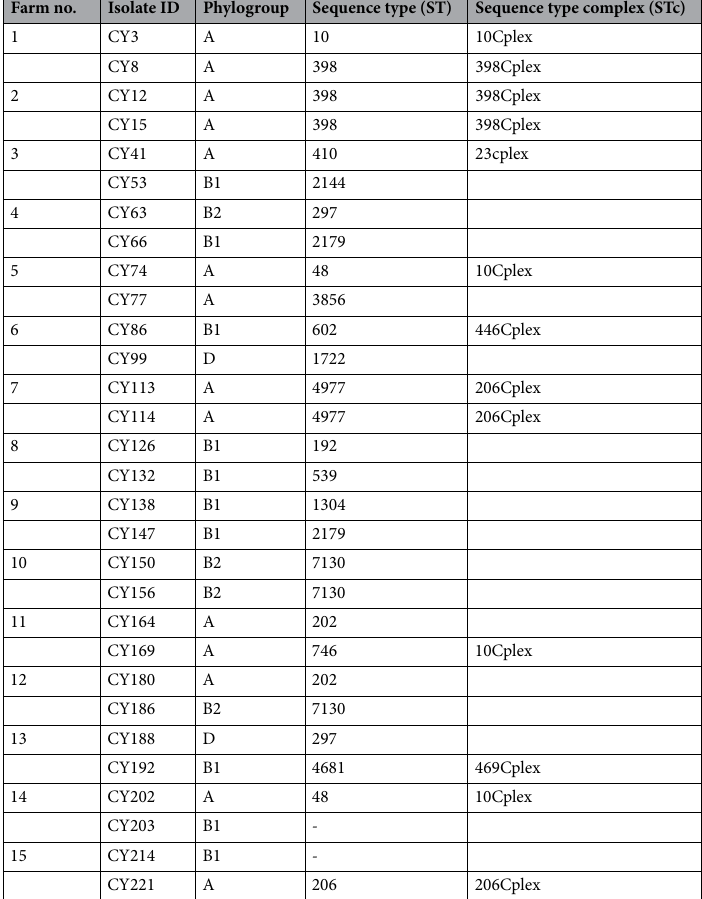
Table 3. Distribution of ESBL producing E. coli isolates into phylogroups, Sequence type (ST) and sequence type complex (STc) identified in the present study (n =